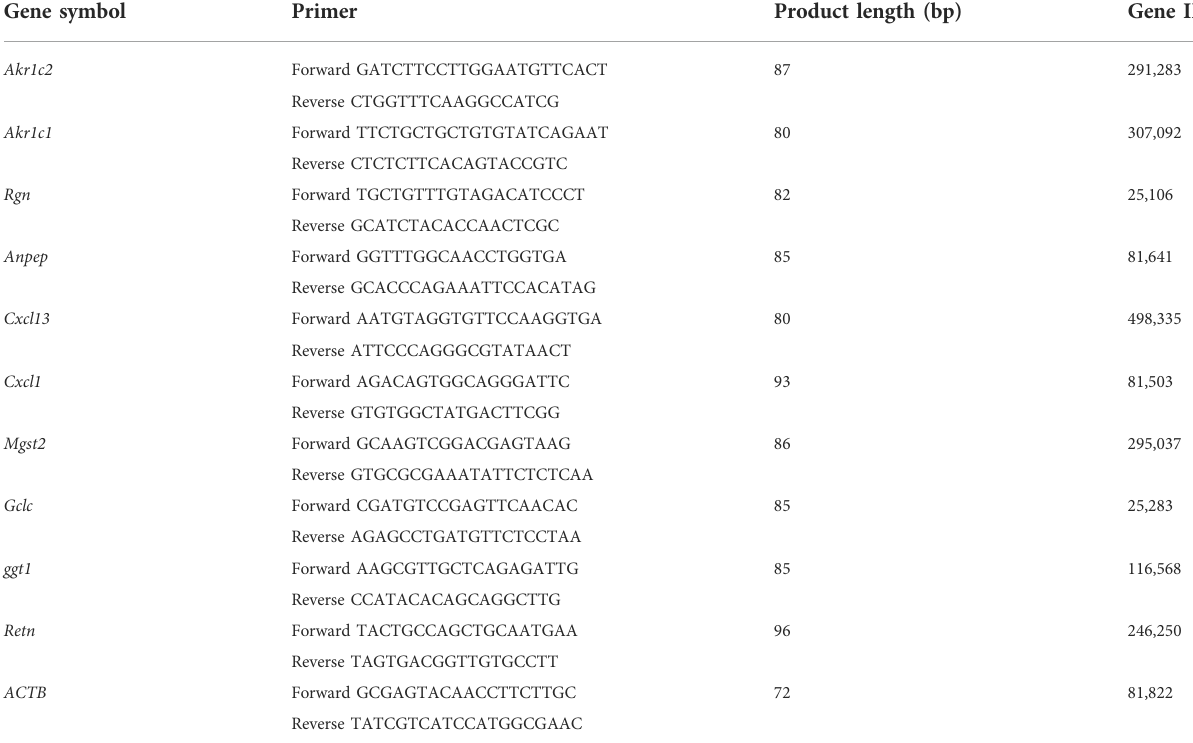
TABLE 1 Primers sequences and